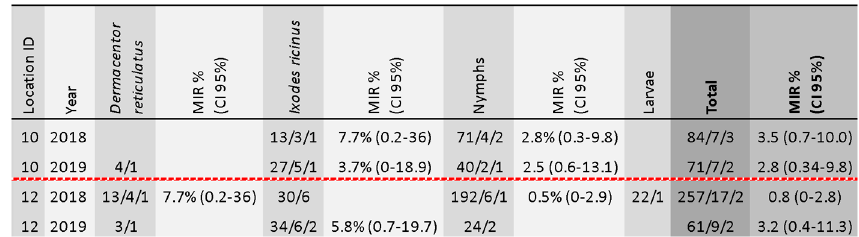
Figure 5. Summary of TBEV positive sample characteristics in ticks. Location ID refers to the map in Figure 1. The sequence of three numbers is explained as follows: total tick sample size/number of pools/number of positive pools.